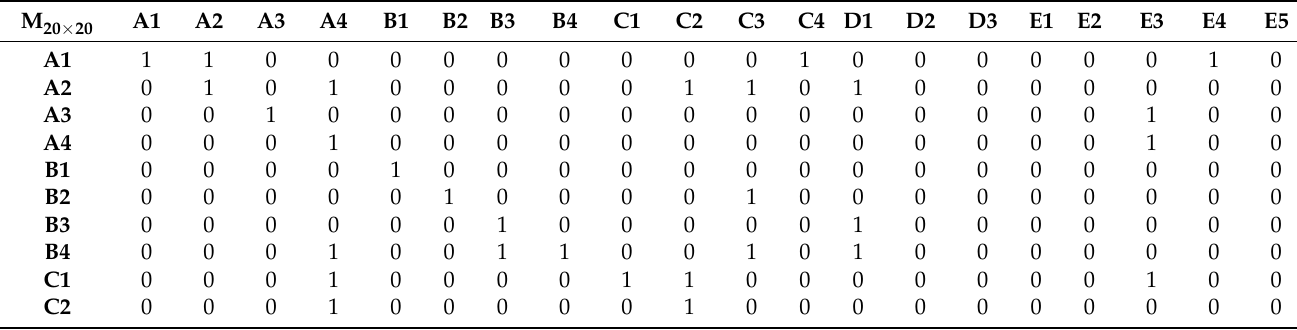
Table A1. Adjacency multiplication matrix B